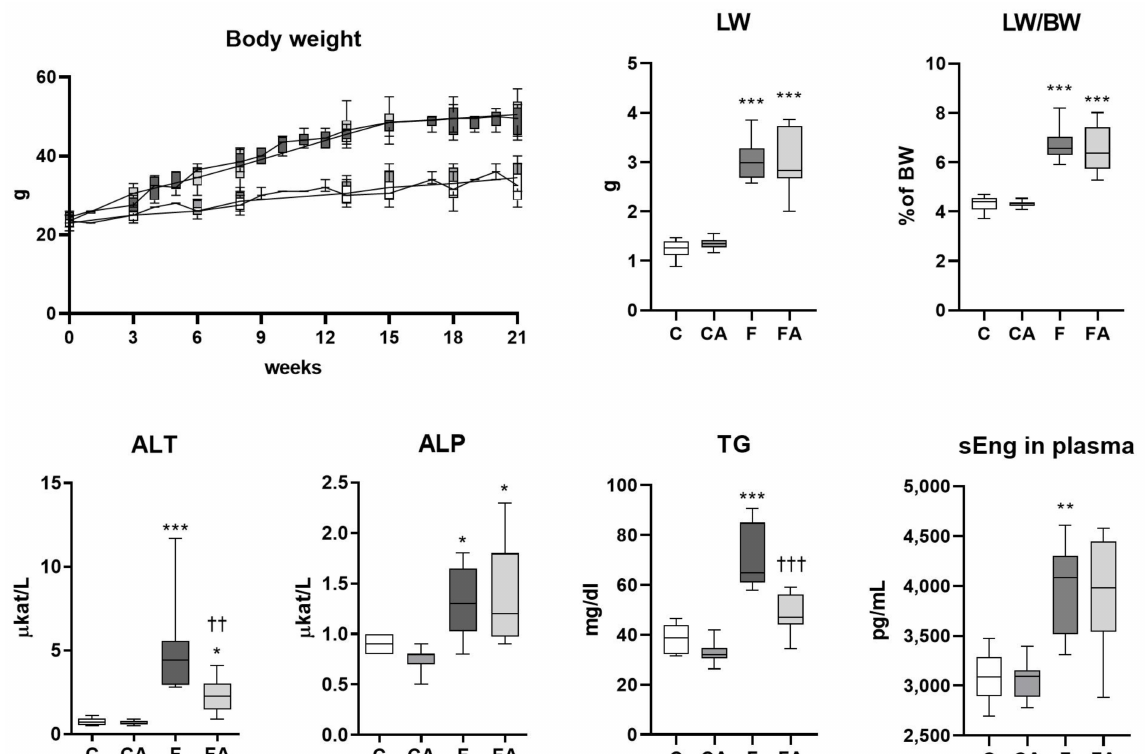
Figure 1. Atorvastatin treatment ameliorated the increased levels of ALT and TG found in the plasma of mice fed a NASH-inducing diet. NASH was induced in mice by 24 weeks of F diet consumption, with atorvastatin (A) administered orally (20 mg/kg/day) during the last three weeks. Corresponding control groups received a chow (C) diet. Abbreviations: BW—body weight, LW—liver weight, ALT—alanine aminotransferase, ALP—alkaline phosphatase, TG – triglycerides, sEng—soluble endoglin. Data are presented as median values, with boxes and whiskers representing the interquartile range and fifth to 95th percentiles, respectively. * p < 0.01, ** p < 0.01, and *** p < 0.001 atorvastatin and/or F-diet vs. vehicle-administered chow diet–treated mice; †† p < 0.01 and ††† p < 0.001 atorvastatin-treated vs. vehicle-treated NASH